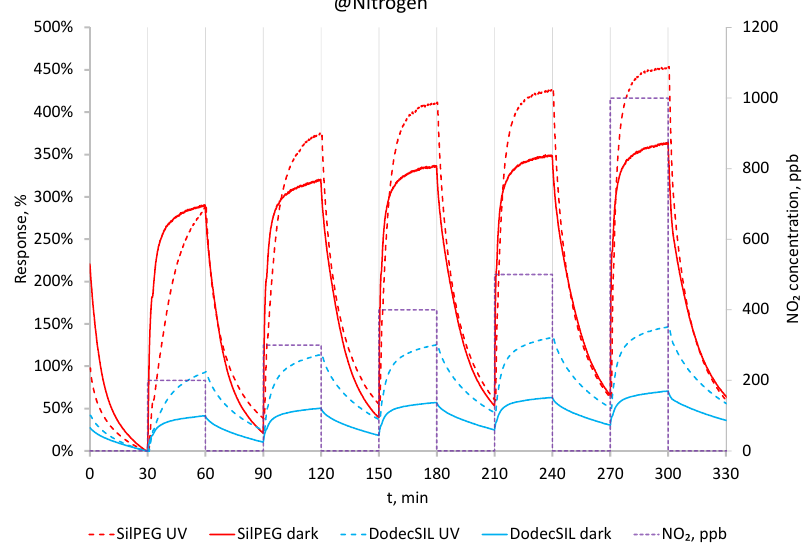
Figure 5. Response to 200–1000 ppb in dark conditions and with UV in N 2 at RT. The same sensing experiments were repeated under UV light activation (Figure 5 dashed lines). In the N 2 atmosphere, activation by UV light increases the sensitivity to NO 2 for both polymers but decreases the response time and does not result in any noticeable improvement in the regeneration of the sensors or in minimising baseline